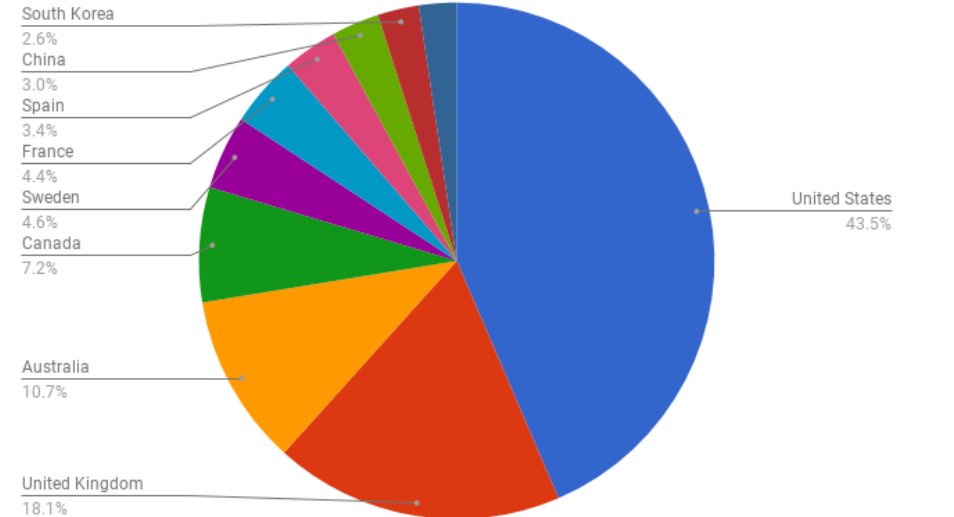
Figure 7. ScratchJr users for each country in Europe